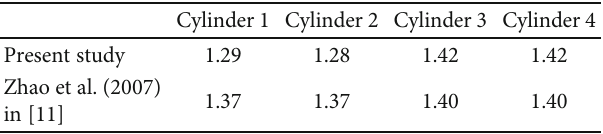
Table 2: Comparison of the simulated maximum run-up to the wave height ratio with Zhao et al. (2007) for a square arrangement.